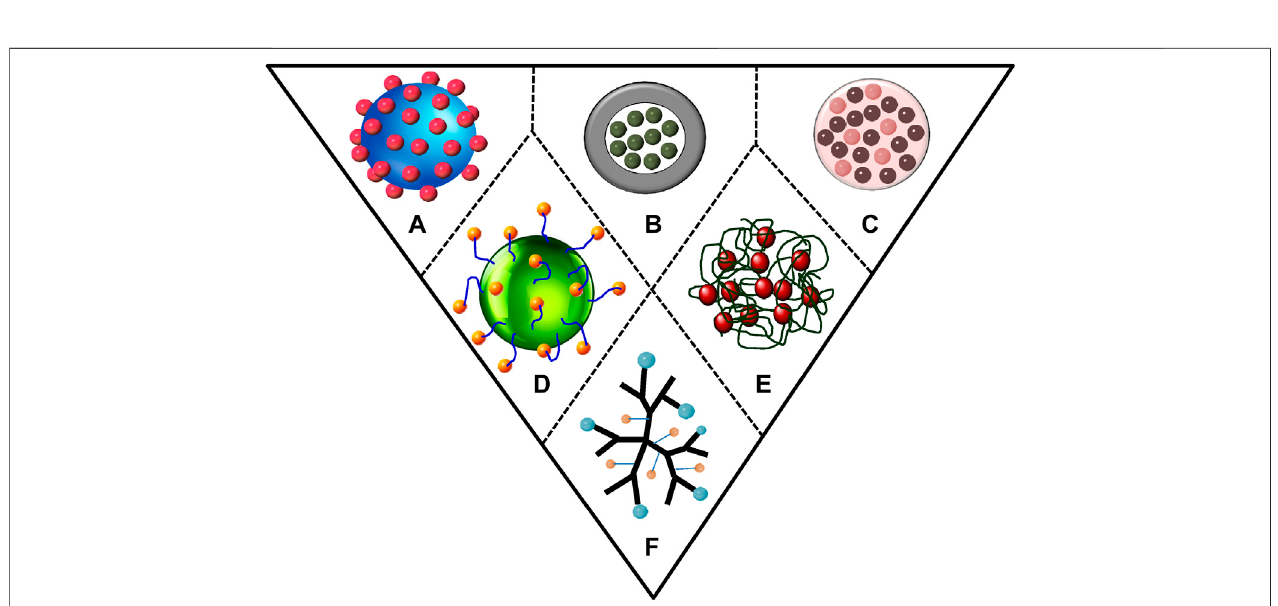
FIGURE 4 | Types of polymer-nanoparticles formulations for delivery of pesticides via (A) adsorption on nanoparticle, (B) encapsulation within polymeric spheres (nanocapsule), (C) entrapment within polymeric nanoparticles (nanosphere), (D) attachment on nanoparticle by different linkers, (E) entrapment within polymeric micelles, and (F) branched and ordered polymeric molecules (dendrimers).